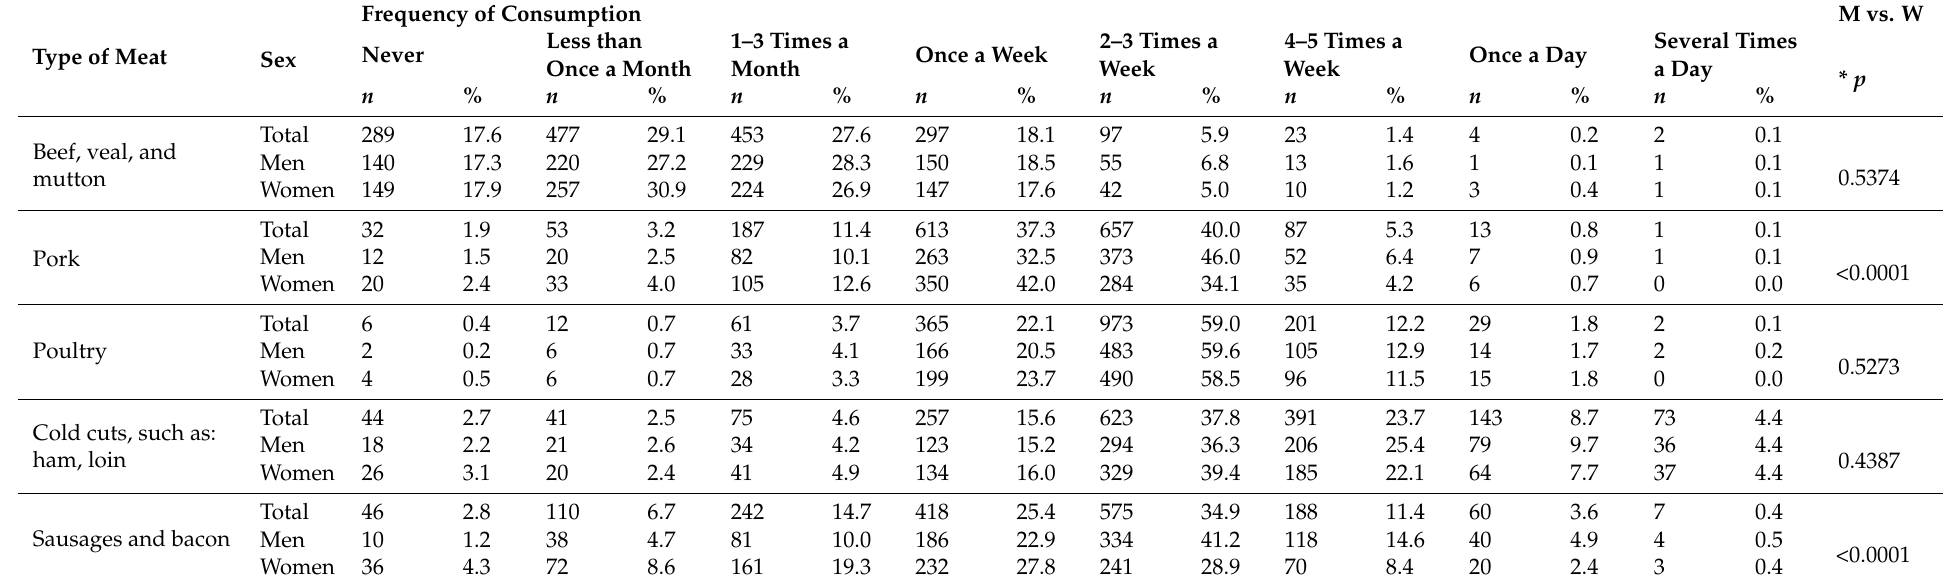
Table 3. Frequency of consumption of selected type of meat and meat